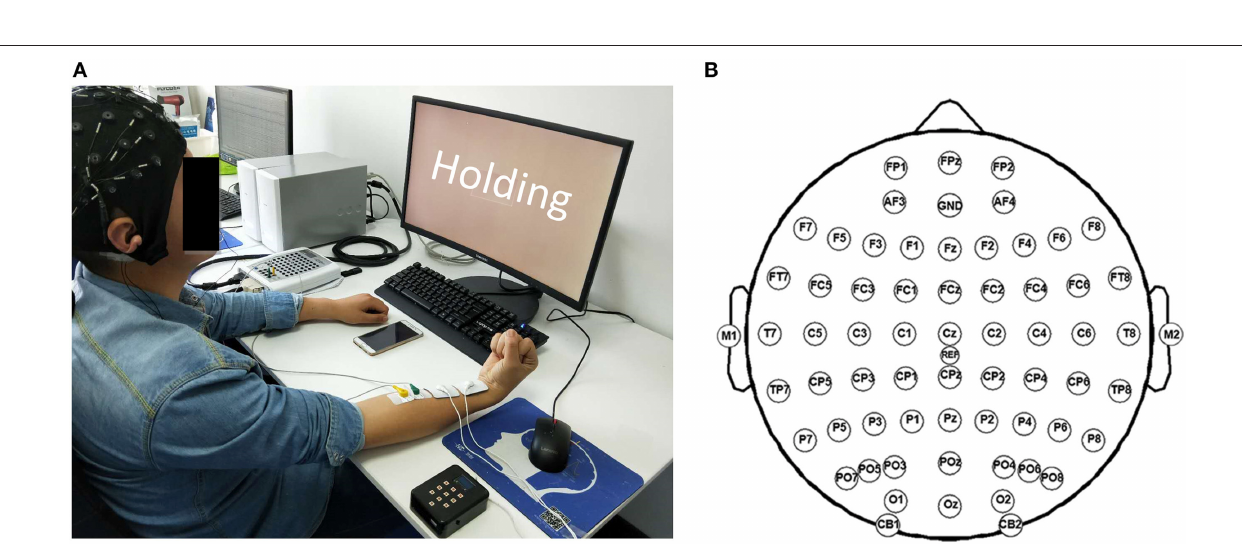
( Figure 1B ). The re-referenced C1 EEG, C3 EEG, C5 EEG, and sEMG data before or after stimulation consisted of 30 data